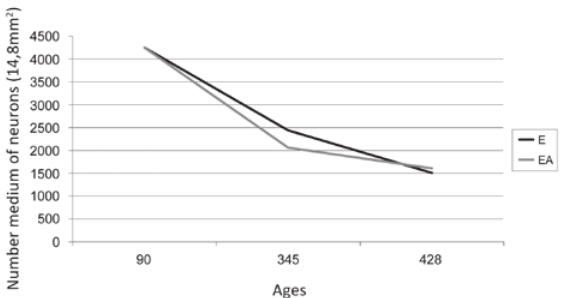
Fig. 2 - Myosin-V immunoreactive myenteric neuron population quantified in a 14.8 mm 2 area of the duodenum of rats with (EA) and without (E) ascorbic acid supplementation at the ages of 90, 345 and 428 days.